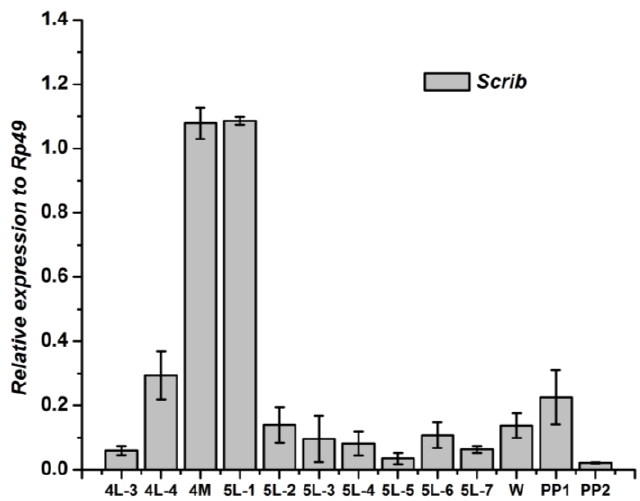
Figure 4. Developmental changes of Scrib mRNA in wingdisc of Bombyx mori.